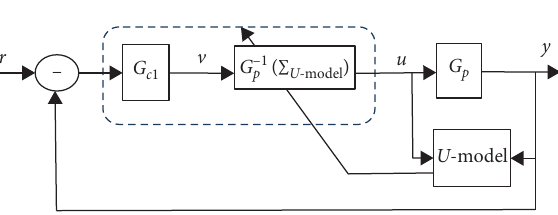
Figure 6: U -model-based adaptive